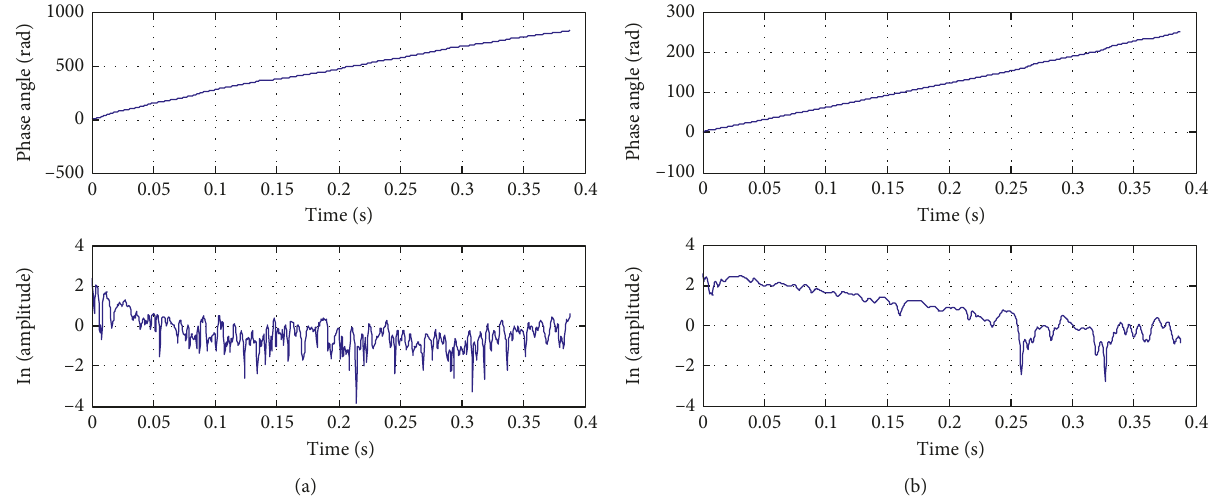
Figure 6: Characteristic plots of the decomposed signals corresponding to two specific frequencies: (a) f